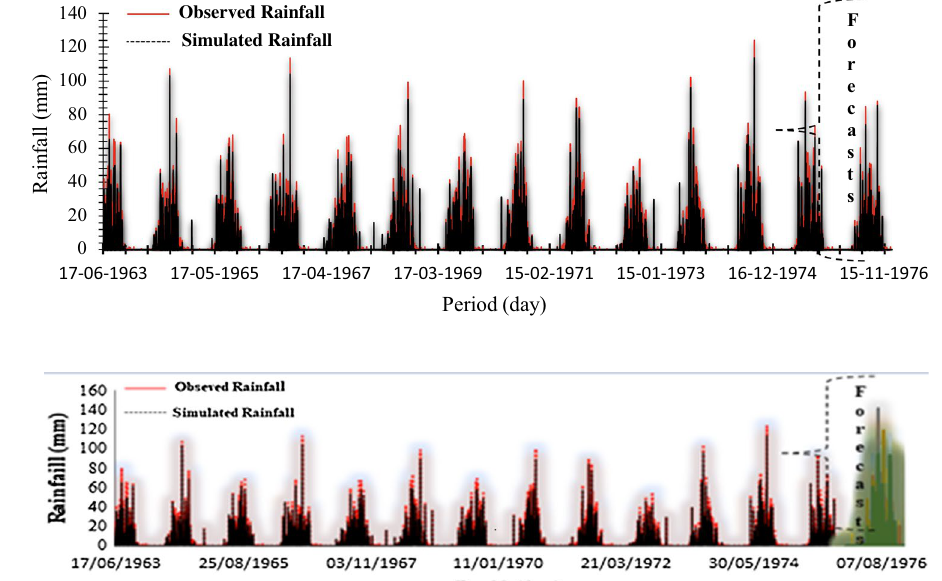
Fig. 6 Evolution of simulated and observed